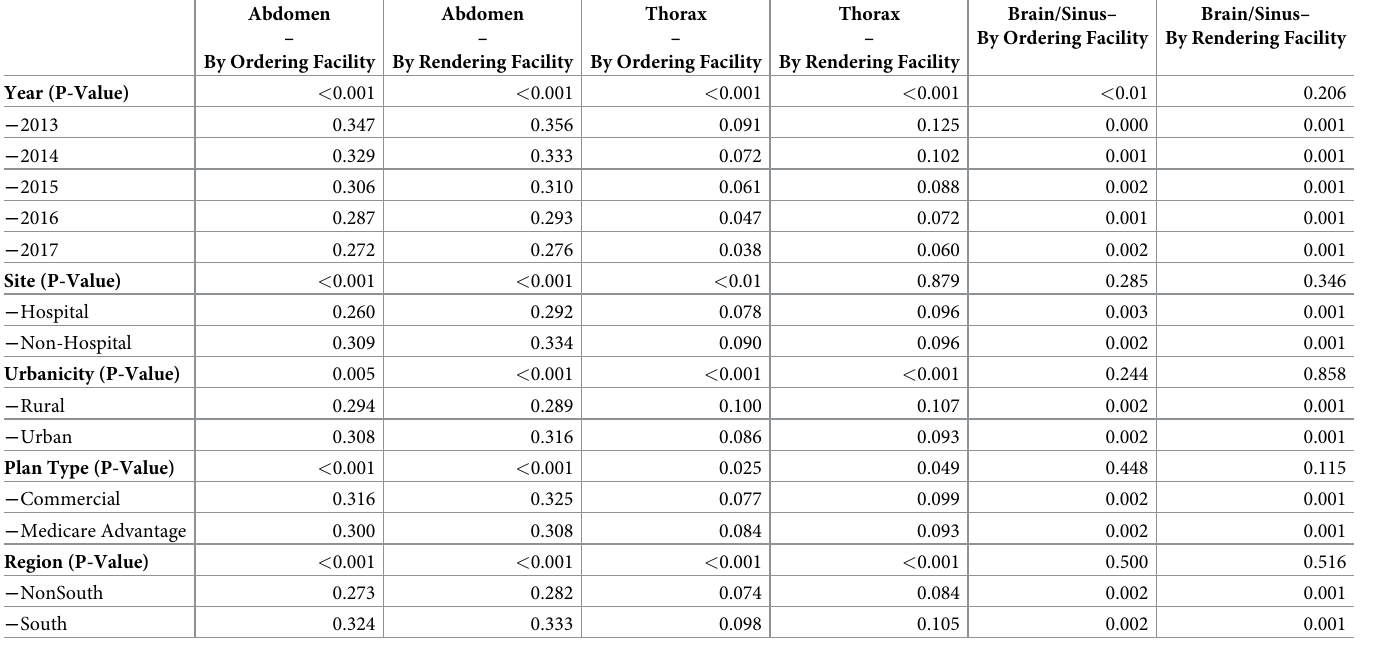
Table 3. Stratified combined imaging